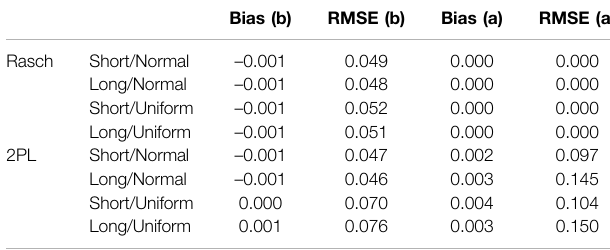
TABLE 1 | Optimal item allocation in second-stage